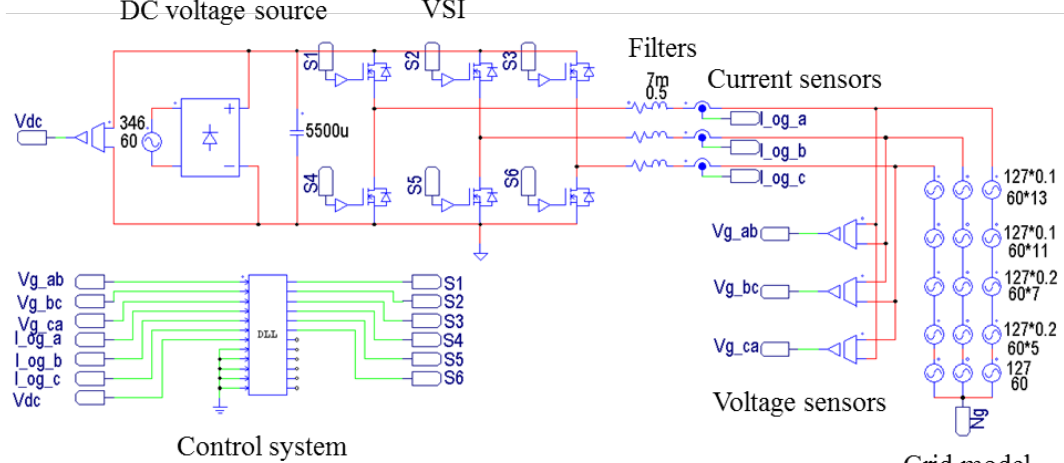
Figure 3. The whole system configuration for simulation. Table 1. System parameters of grid-connected inverter.